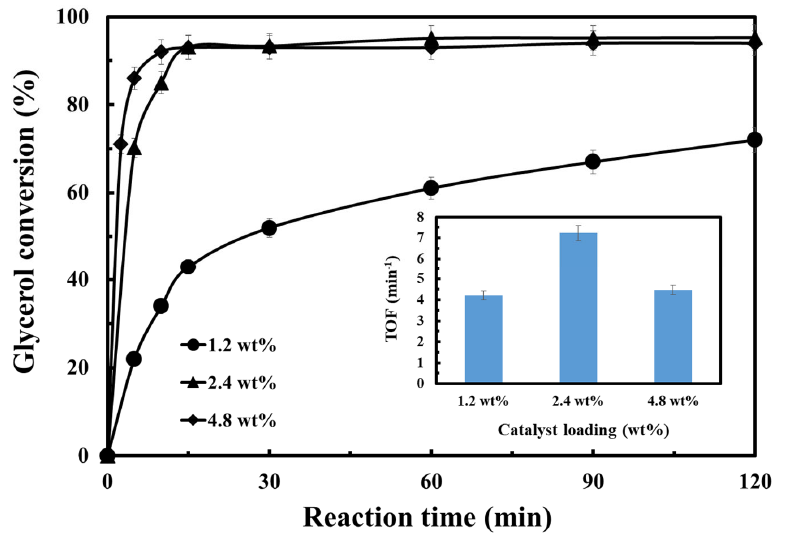
Figure 5. Profiles of glycerol conversion with reaction time at different catalyst loadings under the reaction condition: molar ratio of DMC: glycerol = 2.5, reaction temperature = reaction condition: molar ratio of DMC: glycerol = 2.5, reaction temperature = 60 ◦ C, using kitchen 60 °C, using kitchen countertop blender at 7200 rpm. The inset is TOF at 5 min of countertop blender at 7200 rpm. The inset is TOF at 5 min of different catalyst different catalyst loadings.